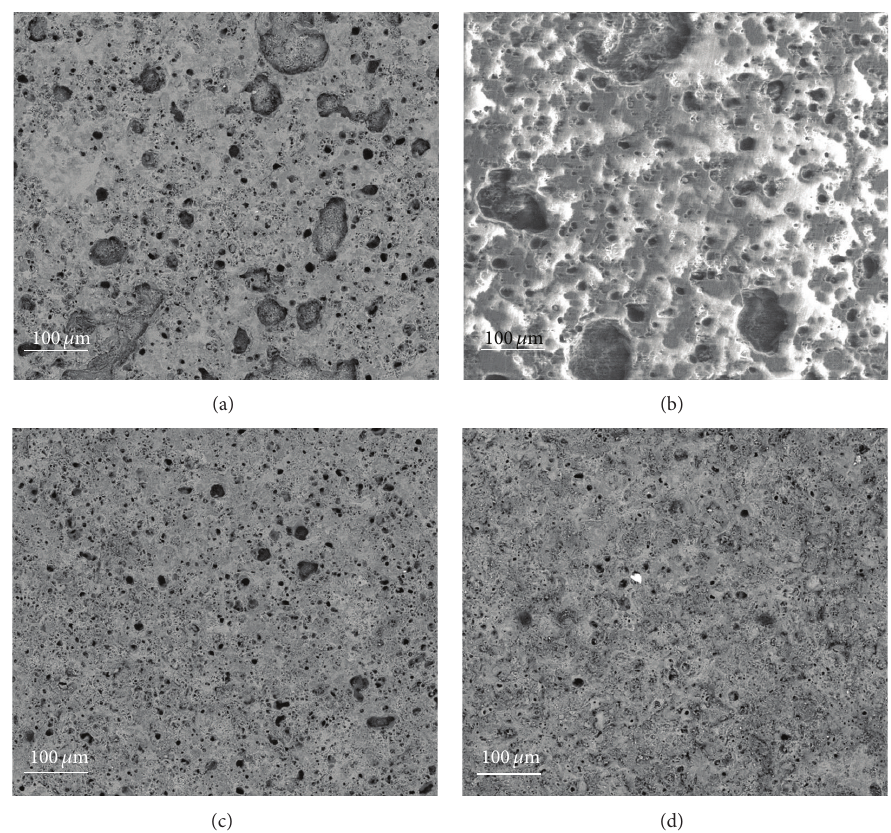
Figure 3: SEM micrographs of the four coating surfaces (a) S1 at 20 𝜇 m thickness, (b) S1 at 30 𝜇 m thickness, (c) S2 at 20 𝜇 m thickness, and (d) S2 at 30 𝜇 m